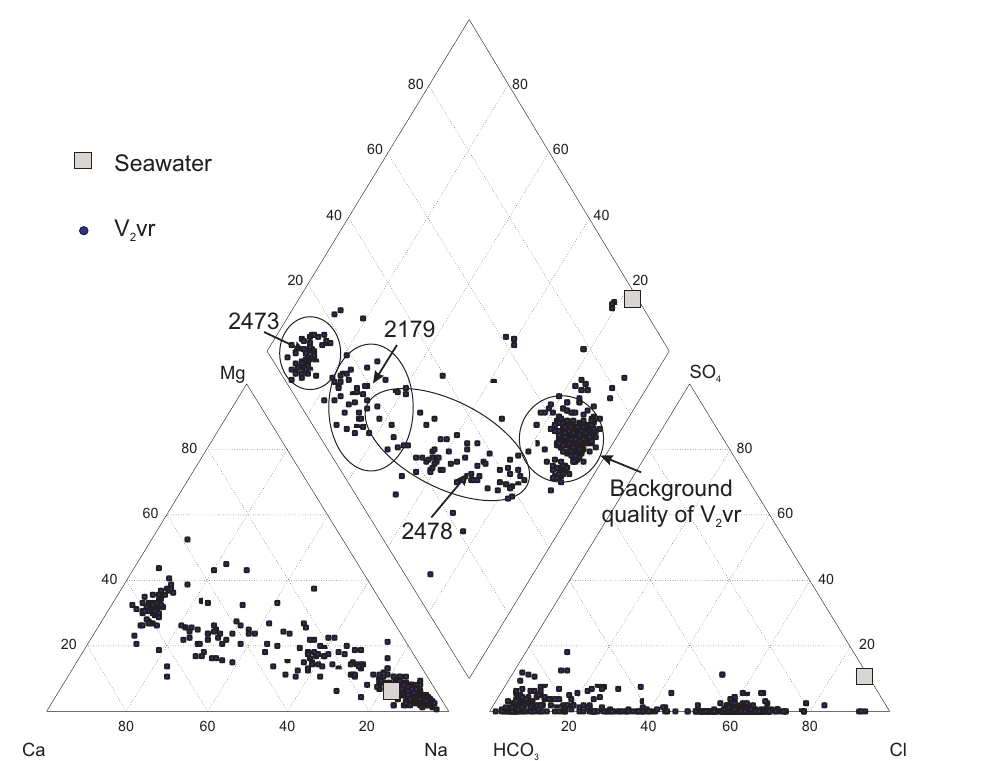
Fig. 11. Piper diagram showing the change in V 2 vr groundwater chemistry caused by the leaking water from buried valleys.